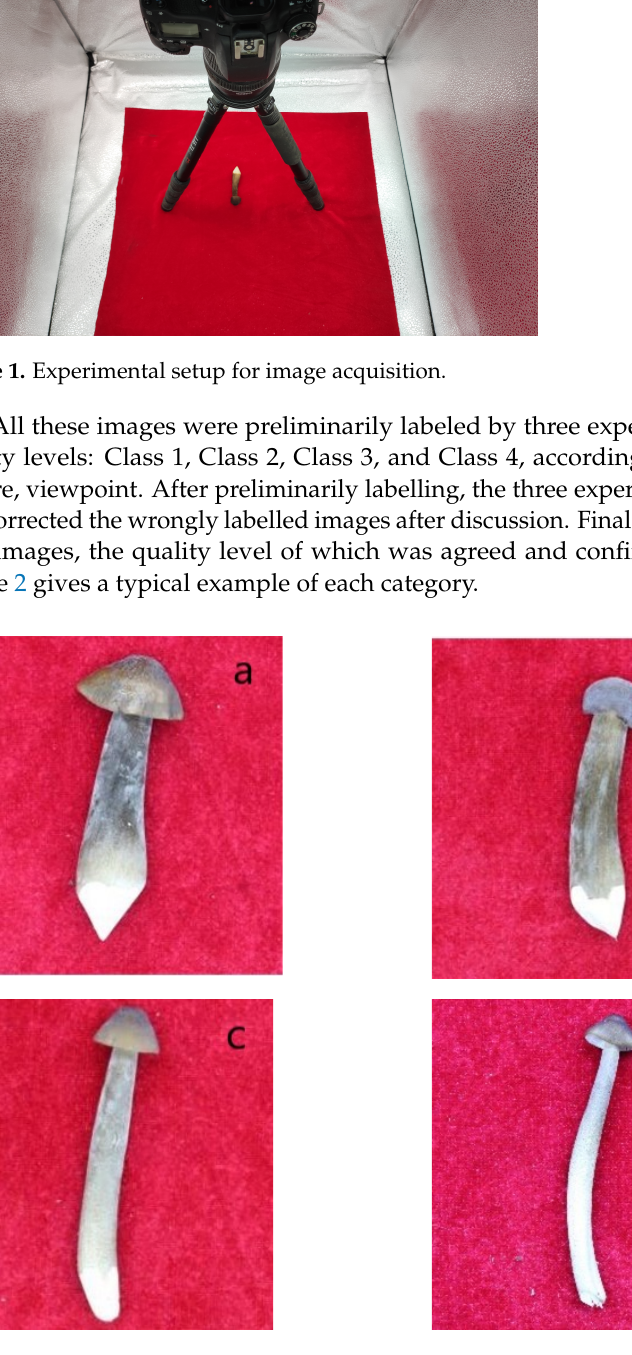
Figure 2. Four quality levels of Oudemansiella raphanipes. ( a ) Class 1; ( b ) Class 2; ( c ) Class 3; ( d ) Class